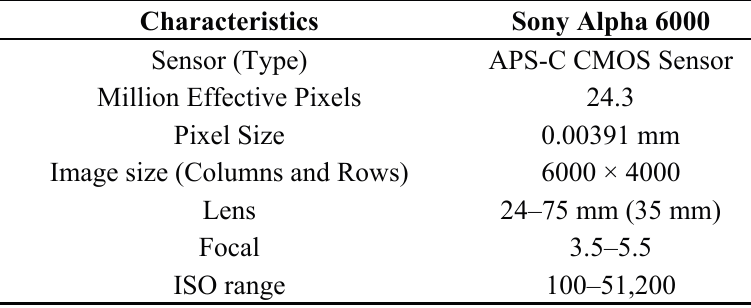
Table 1. Key characteristics for the Sony Alpha 6000 complementary metal oxide semiconductor (CMOS)